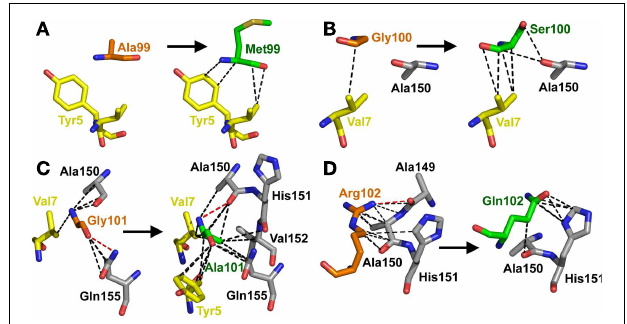
FIGURE 5 |The MSAQ motif (A6c134TCR) makes an increased the number of contacts withA2-Tax compared toAGGR (A6wtTCR) . (A) Differences in contacts made by A 99 (A6wtTCR in orange sticks, left panel) compared to M 99 (A6c134TCR in green sticks, right panel). (B) Differences in contacts made by G 100 (A6wtTCR in orange sticks, left panel) compared to S 100 (A6c134TCR in green sticks, right panel). (C) Differences in contacts made by Gly101 (A6wtTCR in orange sticks, left panel) compared to Ala101 (A6c134TCR in green sticks, right panel). (D) Differences in contacts made by R 102 (A6wtTCR in orange sticks, left panel) compared to Q 102 (A6c134 TCR in green sticks, right panel). In all cases,VdW contacts are shown as black dotted lines (4Å cut-off) and hydrogen bonds/salt bridges are shown as red dotted lines (3.4Å cut-off). Peptide residues are shown as yellow sticks and MHC residues are shown as gray